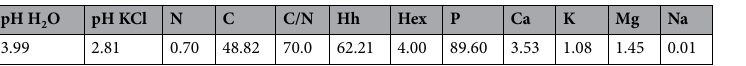
Table 1. The physico-chemical characteristics of substrate used for experiment. C, N (%);Hh– hydrolytic acidity (cmol( +)·kg -1 ), Hex—exchangeable acidity (cmol( +)·kg -1 ); P, Ca, K, Mg and Na (cmol( +)·kg −1